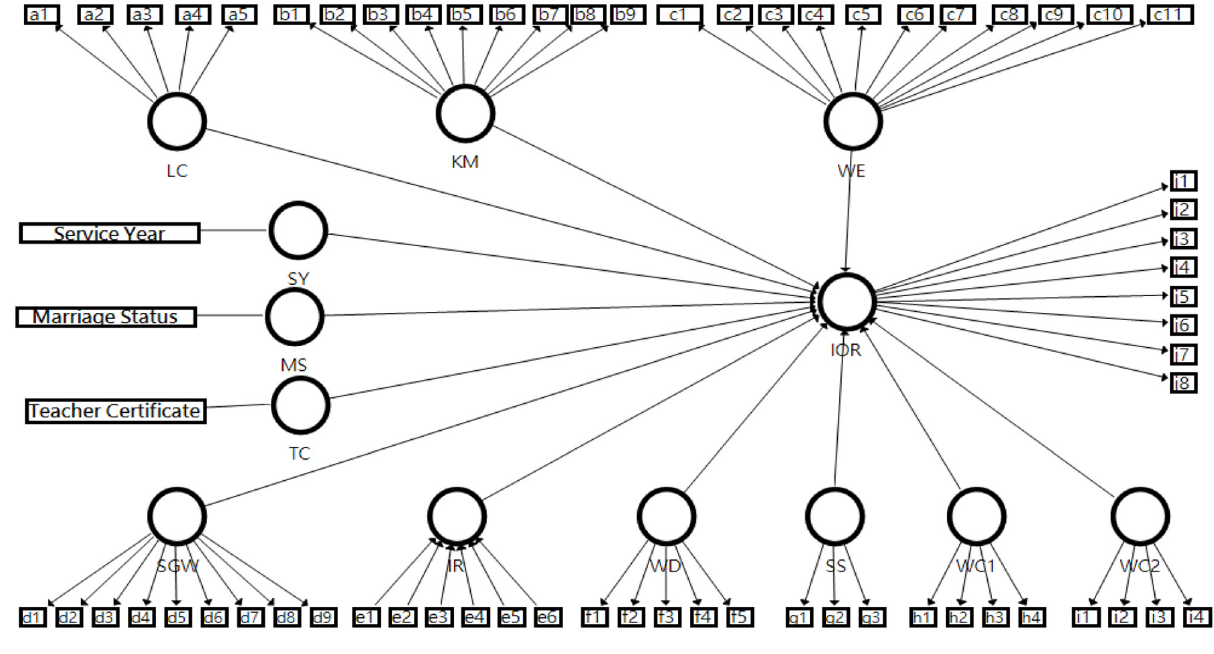
FIGURE 1 | Hypothetical